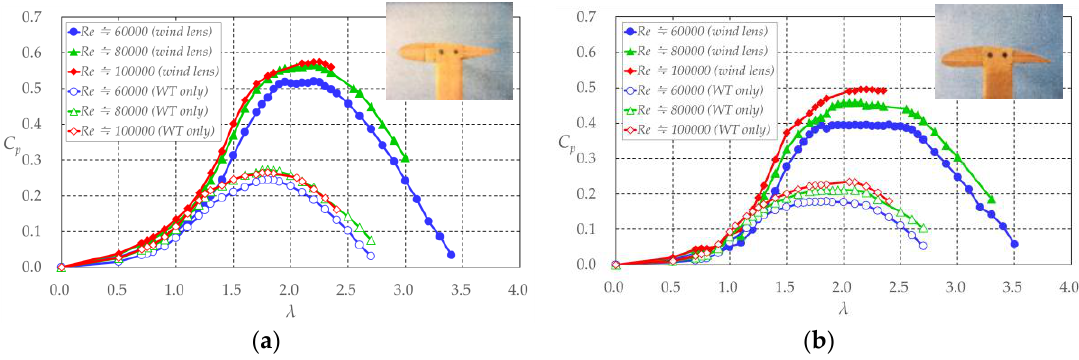
Figure 17. Comparison of power coefficient C p of wind turbines with various Reynolds numbers with and without a wind lens vs. tip speed ratio λ (wind lens: curved-surface-type diffuser). ( a ) NACA0018, symmetric; ( b ) NACA0018, arc-shaped.